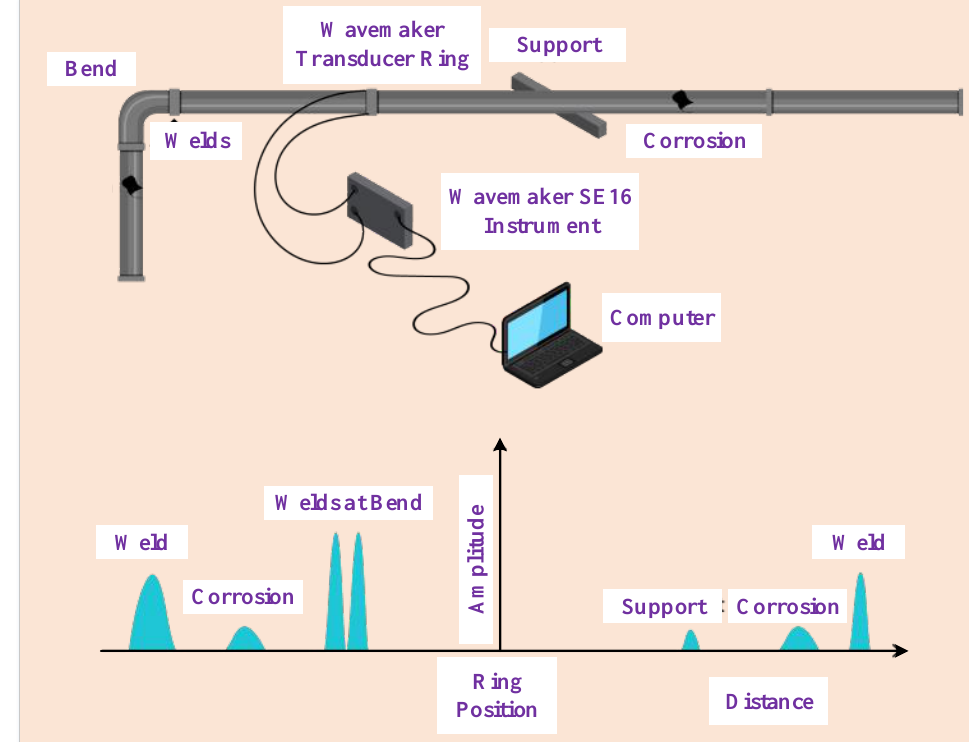
Figure 4. Ultrasonic monitoring for corrosion assessments adopted from